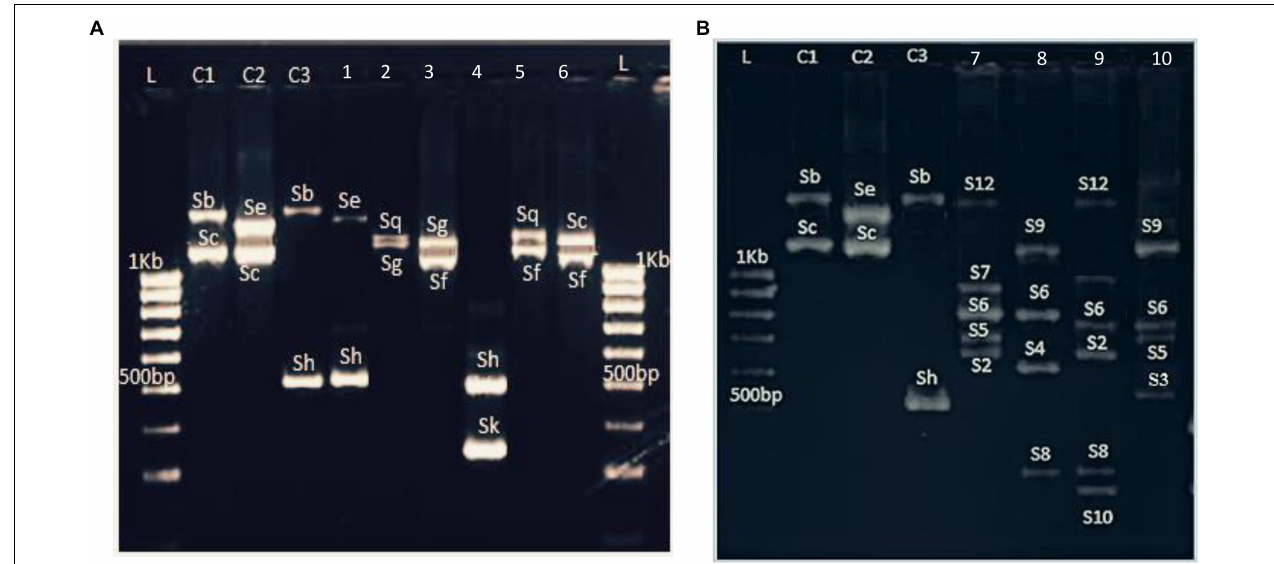
FIGURE 1 | Example of S- allele identification in (A) six P. salicina samples and (B) six hexaploid plums amplified with PruC2-PCER. L: 1KB ladder. C1, C2, and C3: Varieties used as control with previously known S- genotypes. C1, Fortune; C2, Santa Rosa, C3, Beauty; 1, Bedri 1; 2, Aouina Hamra; 3, Tasstour Hamra précoce; 4, Sungold; 5, Ain Dhib; 6, Zaghwenia; 7, Mulata; 8, Negra; 9, Fraila; 10,